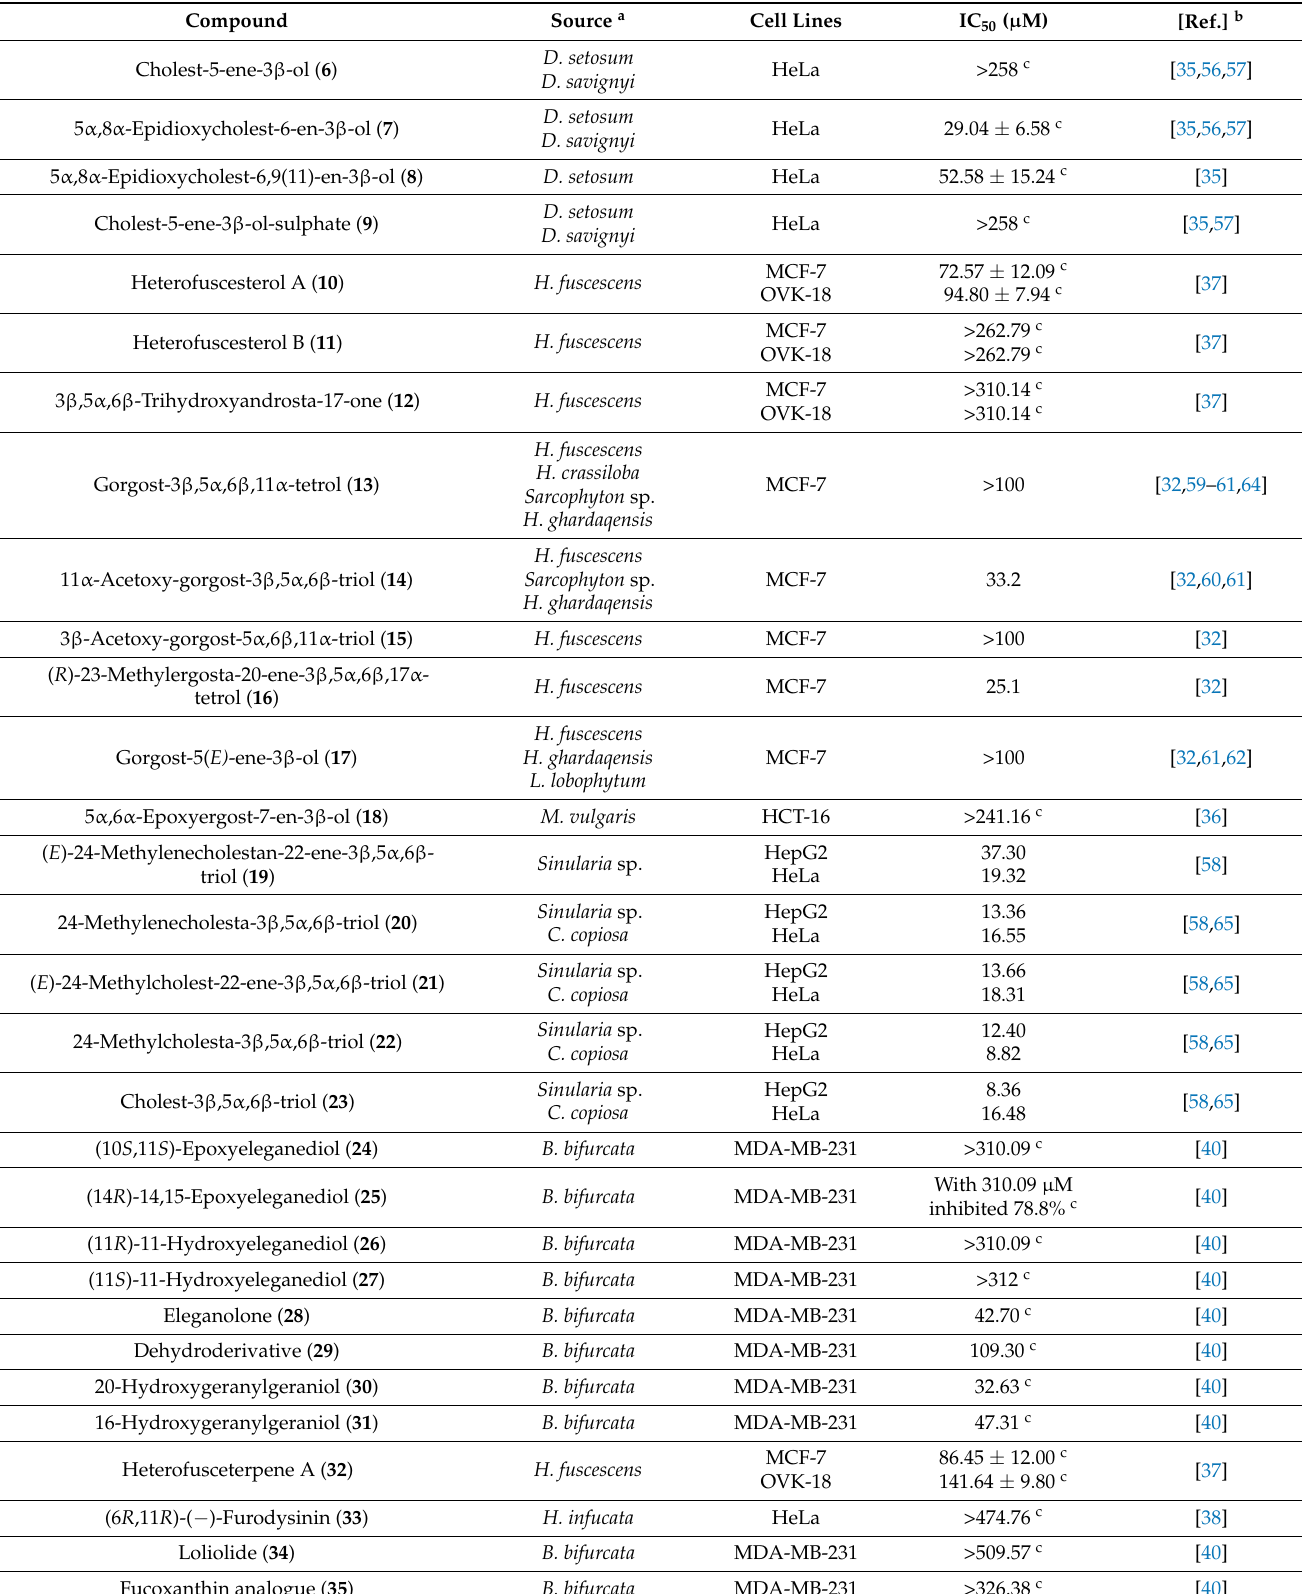
Table 2. Cytotoxicity of terpenoids isolated from marine organisms toward cancer cell